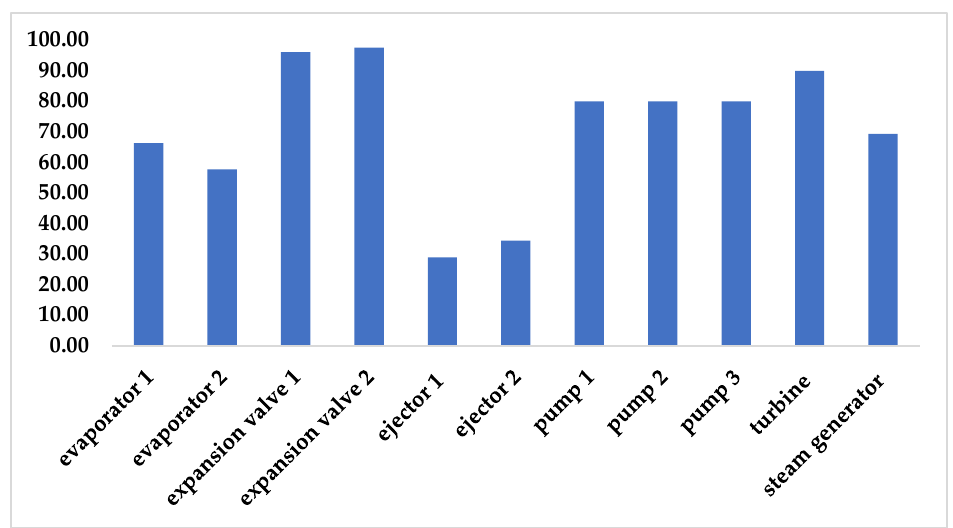
Figure 10. Product components’ exergetic efficiency, %.